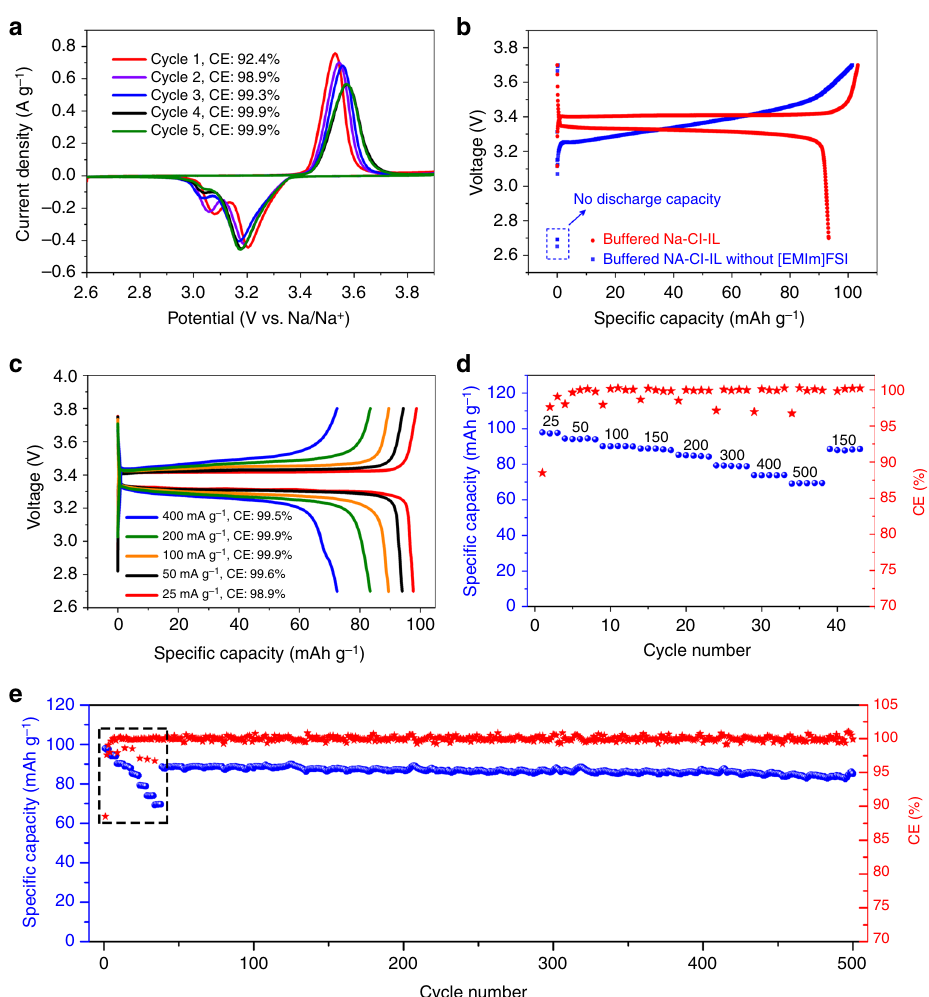
Fig. 3 Na/NVP/@GO cell performances in buffered Na – Cl – IL electrolyte. a CV curves of a Na/NVP@rGO cell using buffered Na – Cl – IL electrolyte at a scan rate of 2 mV s − 1 . b Initial galvanostatic charge-discharge curves of a Na/NVP@rGO cell using buffered Na – Cl – IL electrolytes with and without [EMIm]FSI additive at 25 mA g − 1 . c Galvanostatic charge-discharge curves of a Na/NVP@rGO cell using buffered Na – Cl – IL electrolyte at varied current densities from 25 to 400mA g − 1 . d , e Rate and cyclic stability of a Na/NVP@rGO cell using buffered Na – Cl – IL electrolyte. The boxed region of ( e ) corresponds to the